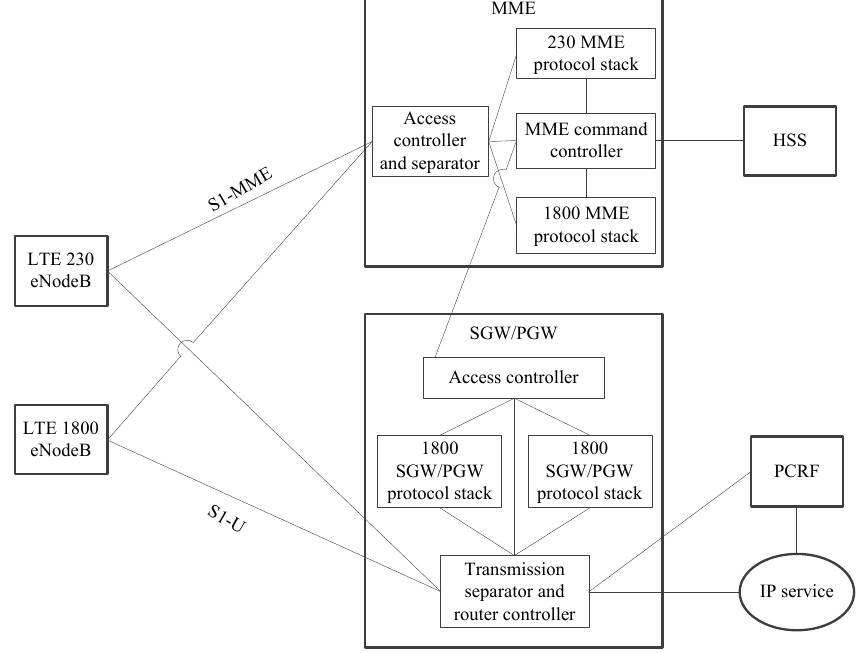
Figure 4. Schematic diagram of the core network integration controller.